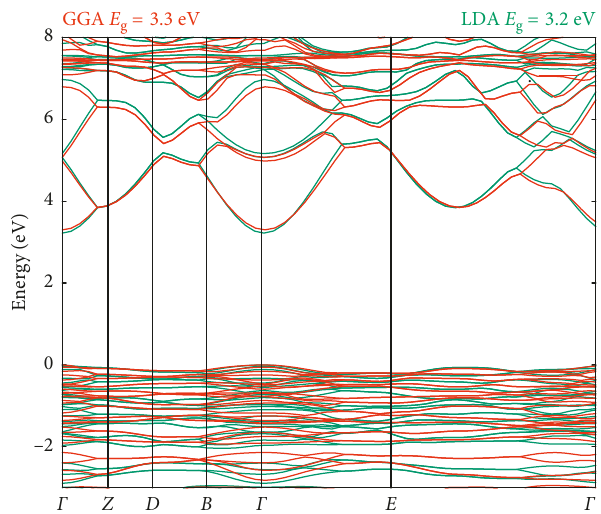
Figure 2: The electronic band structure of crystalline qatranaite determined within LDA (green lines) and GGA (red lines). The zero of the energy scale is shifted to the top of the valence